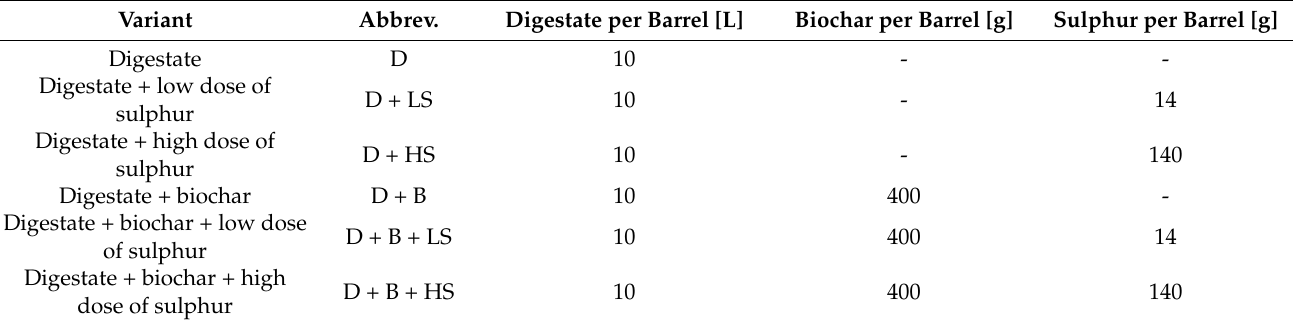
Table 2. Experimental variants of